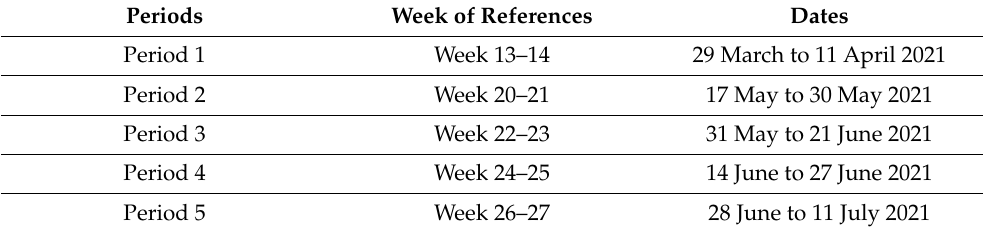
Table 1. Time periods considered for trend